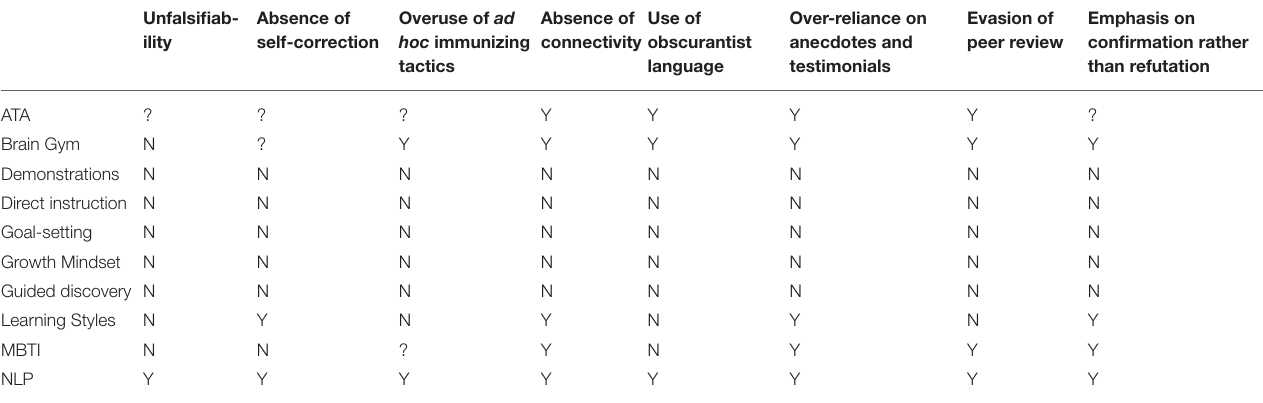
TABLE 1 | Evaluation of brain-based and learning theories against characteristics of pseudoscientific theories (Lilienfeld et al., 2003; Koertge, 2013; Main sources: Bailey, 2017 ). Unfalsifiab-